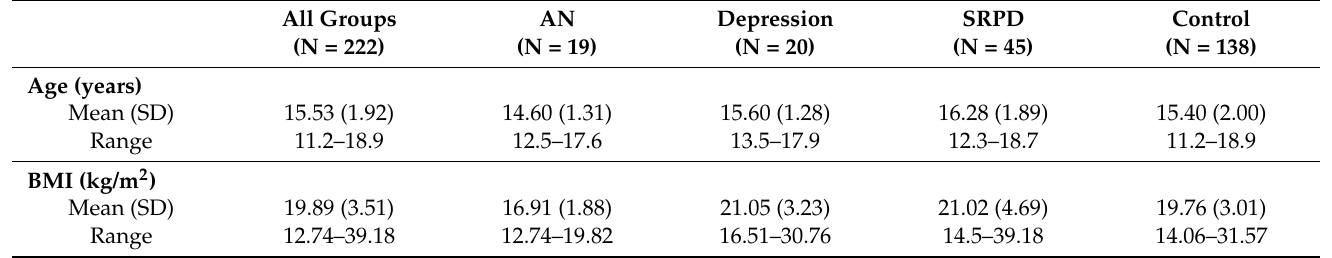
Table 1. Means and standard deviations (SDs) of age and BMI (body mass index) by group (AN, anorexia nervosa; SRPD, self-reported psychiatric diagnosis; BMI, body mass index).